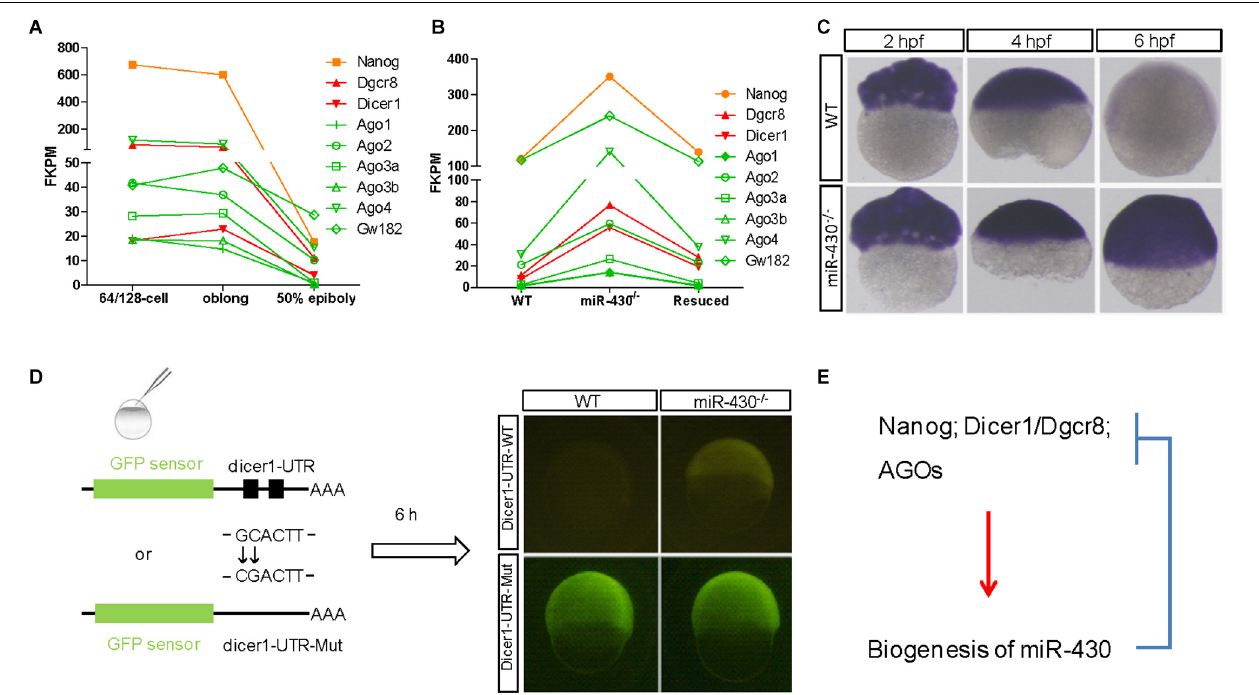
FIGURE 6 | A reciprocal regulatory loop for miR-430 in the clearance of maternal transcript. (A) The transcripts of Nanog , Dicer1 , Dgcr8 , and AGOs were maternally provided. (B) The maternally provided transcripts Nanog , Dicer1 , Dgcr8 , and AGOs were significantly increased in the miR-430 − / − mutants and down-regulated in the rescued embryos at shield stage. (C) WISH detection of Dicer1 transcripts in the WT and miR-430 − / − mutants. The Dicer1 transcripts were maternally provided and degraded at shield stage in the WT but not miR-430 -deficient embryos. (D) Repression of Dicer1 by miR-430 thorough miR-430 binding sites in their 3 (cid:48) UTR. Two miR-430 binding sites (GCACTT) were identified in the 3 (cid:48) UTR of Dicer1 . GFP sensors with Dicer -3 (cid:48) UTR-WT and Dicer -3 (cid:48) UTR-Mut (two-nucleotide mutations in the miR-430 binding sites) were injected into embryos and fluorescence was examined at 6 hpf. (E) A proposed reciprocal regulatory loop between maternally provided transcripts and miR-430